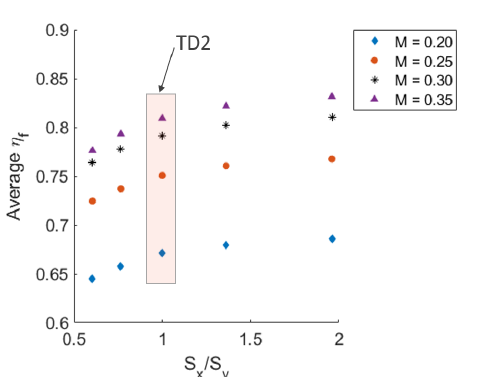
Figure 8. The area-averaged film effectiveness is compared to the ratio of spanwise and streamwise spacing for TD2-base geometry for four blowing ratios. The original design with S x = S y = 3.5 D is highlighted for reference.